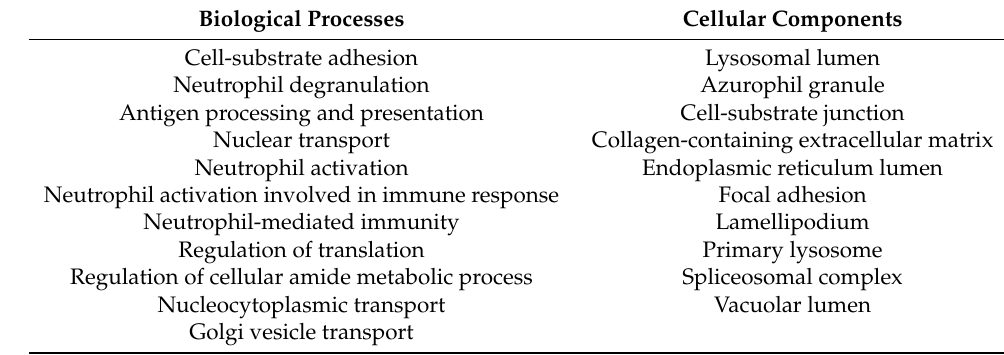
Table 3. Biological processes and cellular processes common to all EV pellets across all mesothelioma cell lines.